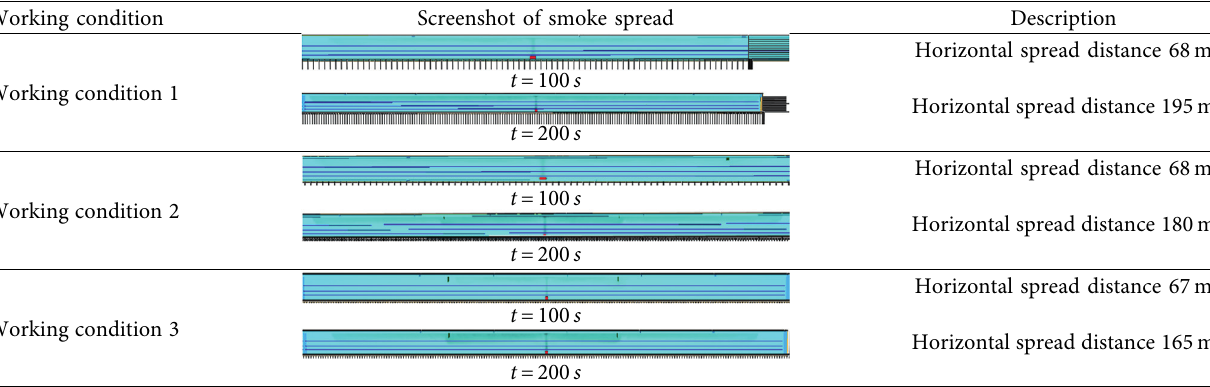
Table 3: Comparison of smoke spread under working conditions 1, 2, and 3.